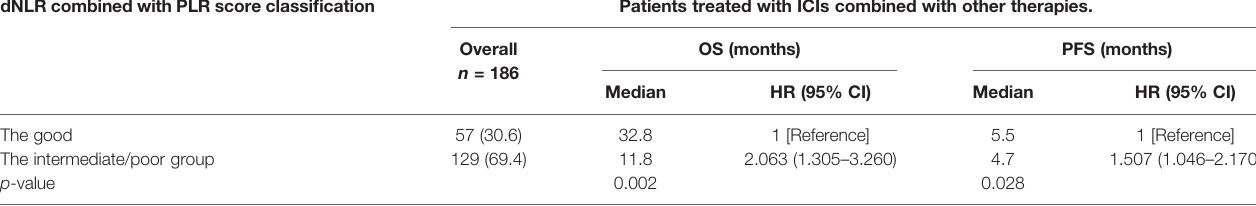
TABLE 9 | Univariate analyses of the good group and the intermediate/poor group associated with OS and PFS of AGC patients treated with ICIs combined with other therapies. dNLR combined with PLR score classi fi cation Patients treated with ICIs combined with other therapies.